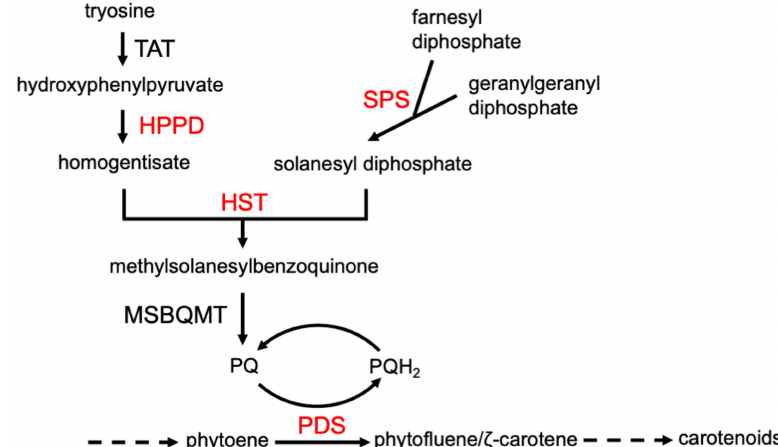
Figure 4. Some of the enzymes (largest font) required for synthesis of carotenoids, the inhibition of which causes a white phenotype. Those in red are targets of synthetic herbicides. TAT = tyrosine amino transferase, HPPD = hydroxyphenylpyruvate dioxygenase, HST = homogentisate solanesyltransferase, SPS = solanesyl diphosphate synthase, PDS = phytoene desaturase, MSBQMT = methylsolanylbenzoquinone methyl transferase. Plastoquinone (PQ) is a PDS cofactor.